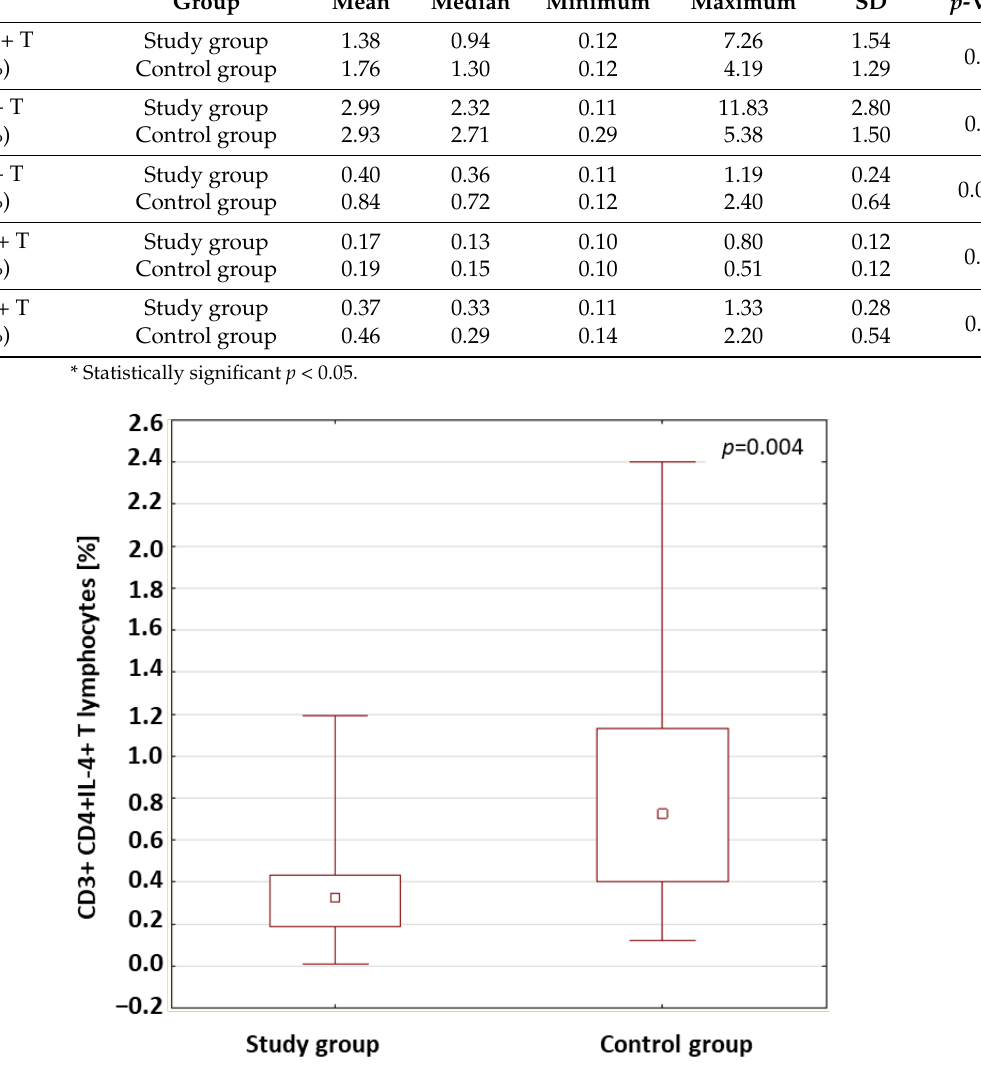
Figure 2. Comparison of the percentages of CD3+CD4+ T cells with intracellular expression of IL-4 in the study group and the control